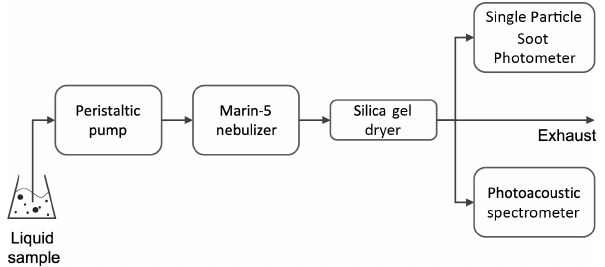
Figure 1. Schematic of the instrumental setup used in the present